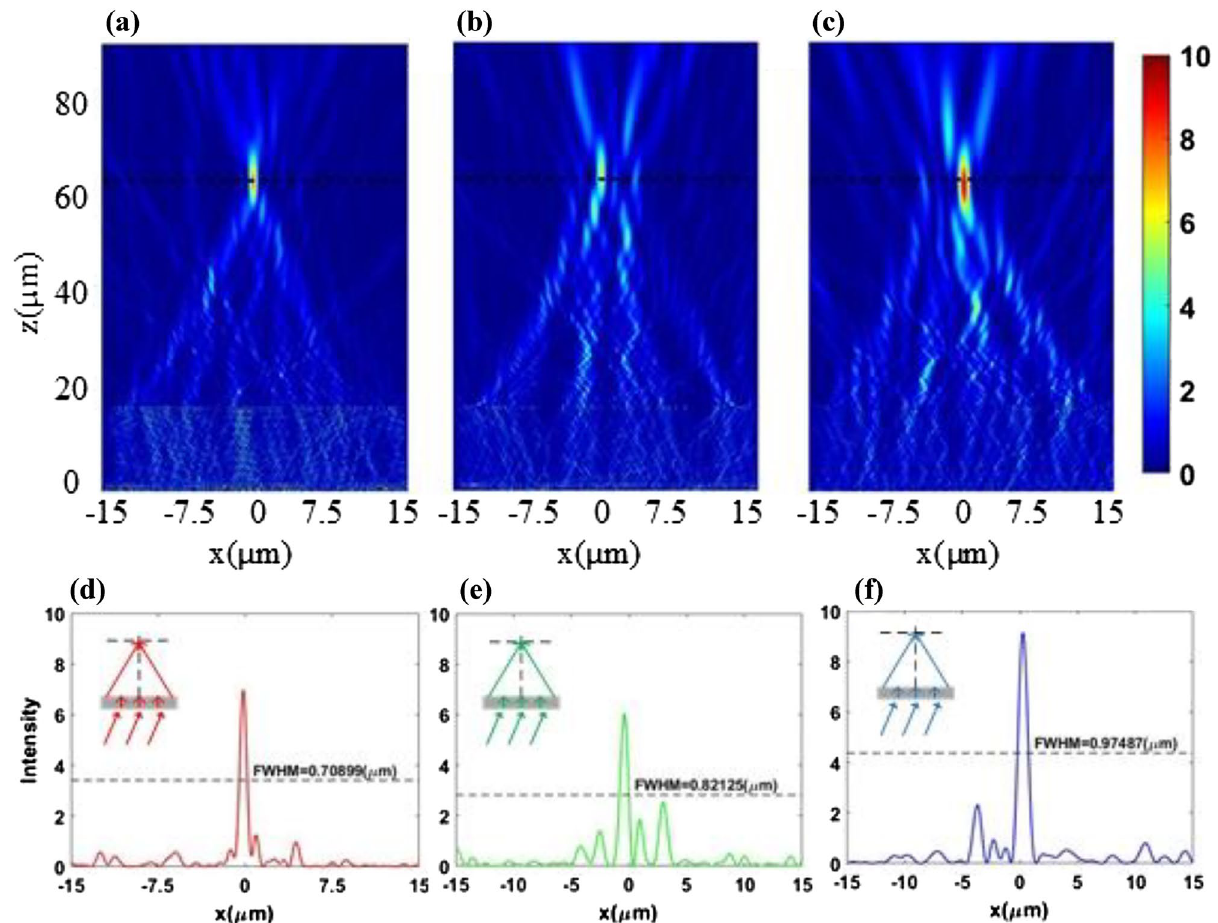
Figure 8. ( a – c ) Simulated electric field intensity distribution of double-layers metasurface at the wavelengths of 470 nm, 530 nm and 630 nm, respectively. ( d – f ) Simulated electric field intensity distribution of focal plane at the wavelengths of 470 nm, 530 nm and 630 nm,